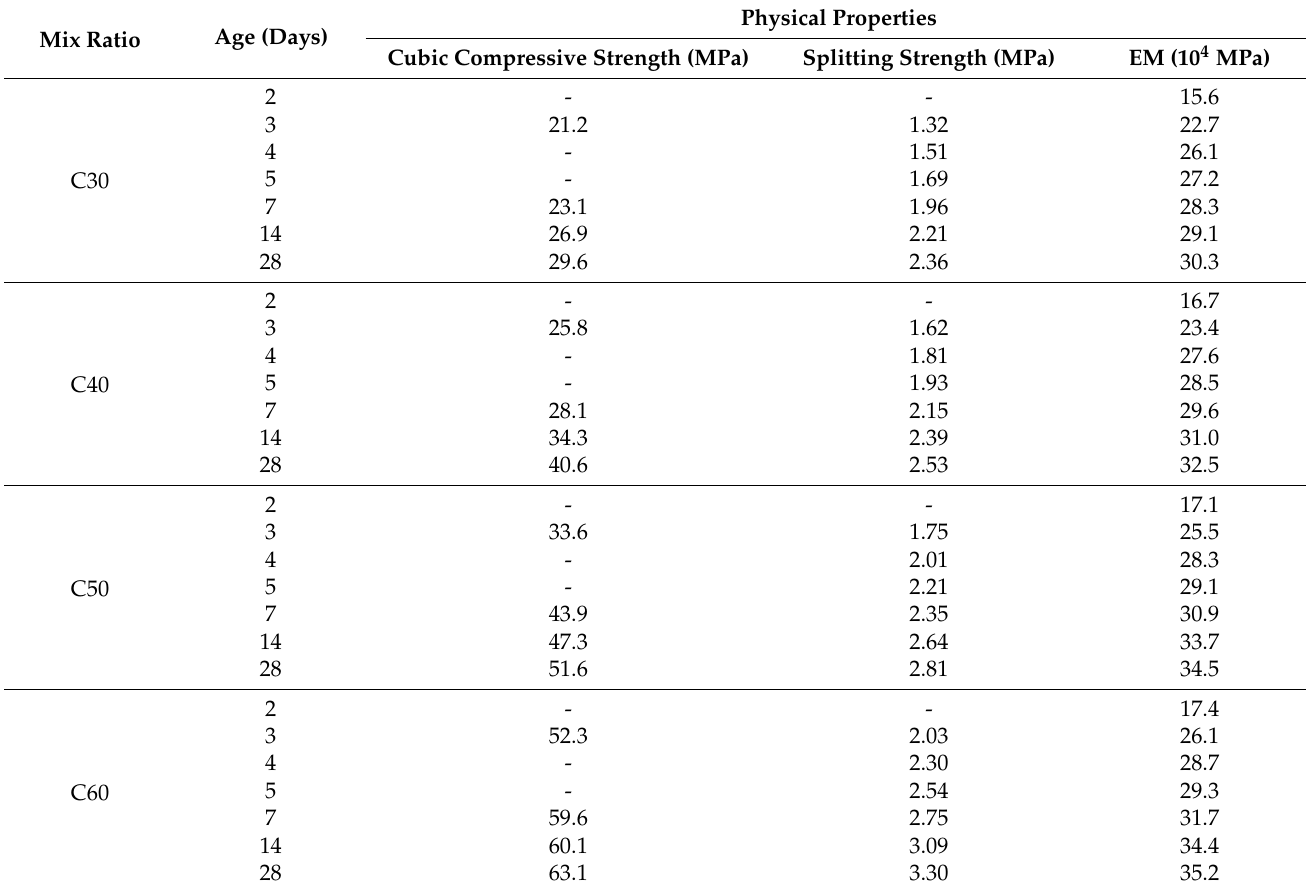
Table 5. Characteristics of steel